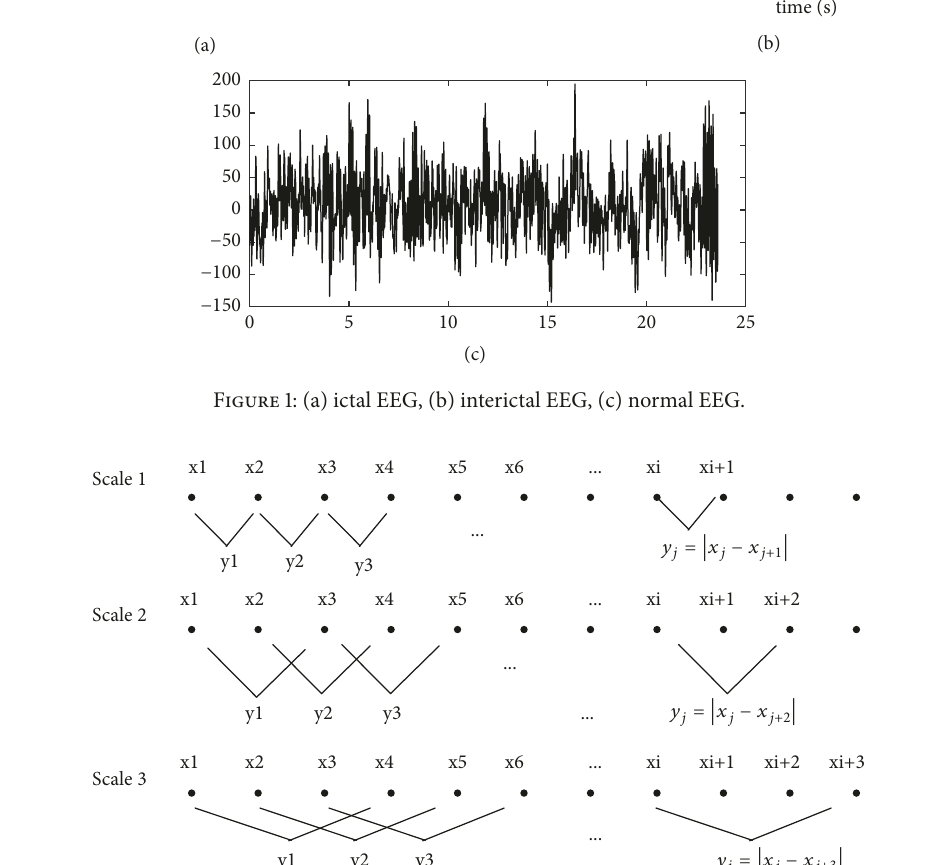
and squares. Various alternate lines of discrimination (dis- crimination boundaries) are shown in Figure